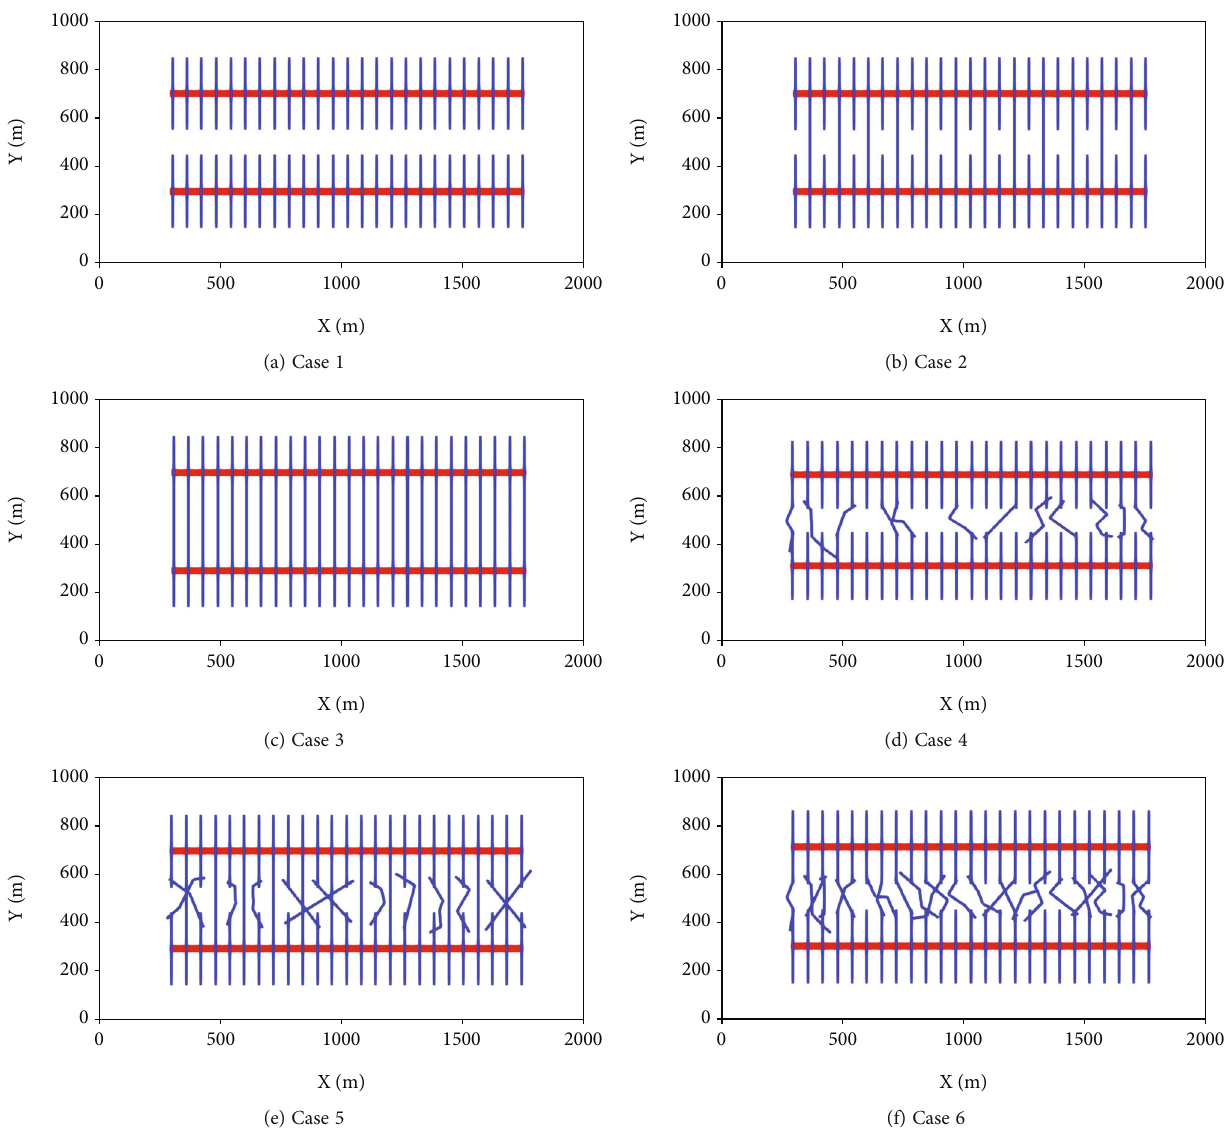
Figure 2: Distribution of horizontal wells and hydraulic fractures as well as natural fractures. (a) Two horizontal wells are not directly connected. (b) Two horizontal wells are connected through partial hydraulic fractures. (c) Two horizontal wells are connected through all hydraulic fractures. (d) Two horizontal wells are connected through partial natural fractures. (e) Two horizontal wells are connected through both hydraulic fractures and natural fractures. (f) Two horizontal wells are connected through numerous natural